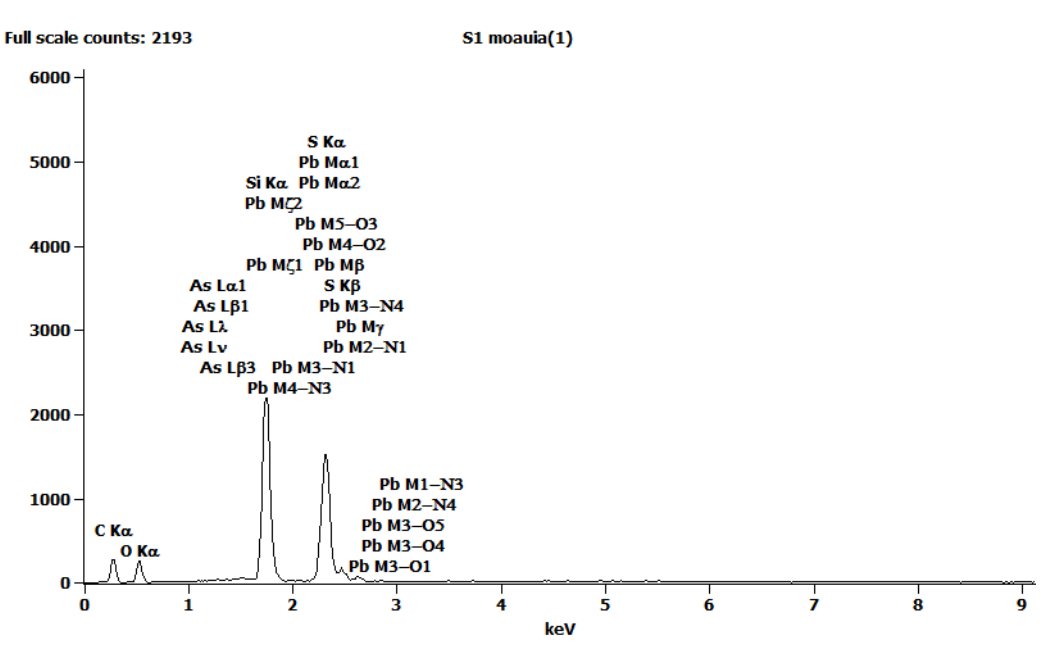
Figure 11. SEM images of adsorbent 2 after adsorption.